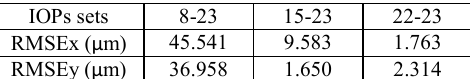
arranged in the block were surveyed with double frequency GNSS receivers and six were used as control and other thirteen as check points. Two bands of cfg. 1 were selected for this empirical assessment: band 8 (609.79 nm, Sensor 2) and Table 7. Results of ZROT method comparing sets of pairs of band 23 (786.16, Sensor 1) which do not correspond with sets of IOPs. those with the same id for the calibration set in which cfg. 2 was used.